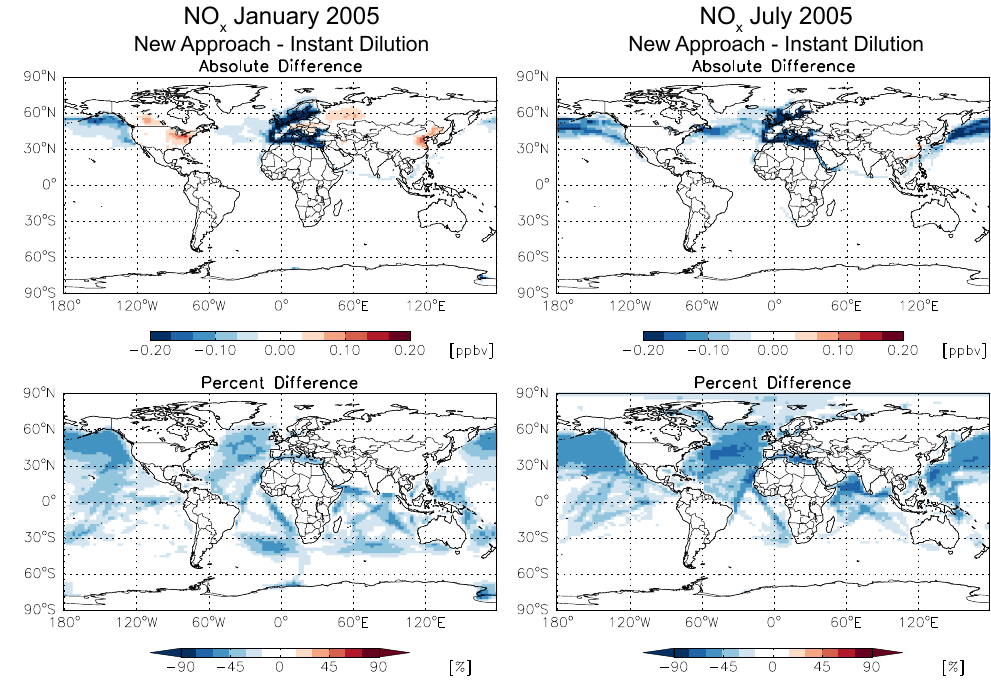
Fig. 6. Differences between instant dilution and plume-in-grid simulations of NO x concentrations in January and July 2005. Results are Fig. 6. Difference plots between monthly mean global NO x concentrations simulated with GEOS-Chem shown for the lowest GEOS-Chem model layer (0–0.12km). for January and July 2005 for the instant diluting model and the new LUT approach model simulations, for the lowest model layer (0–0.12 km).